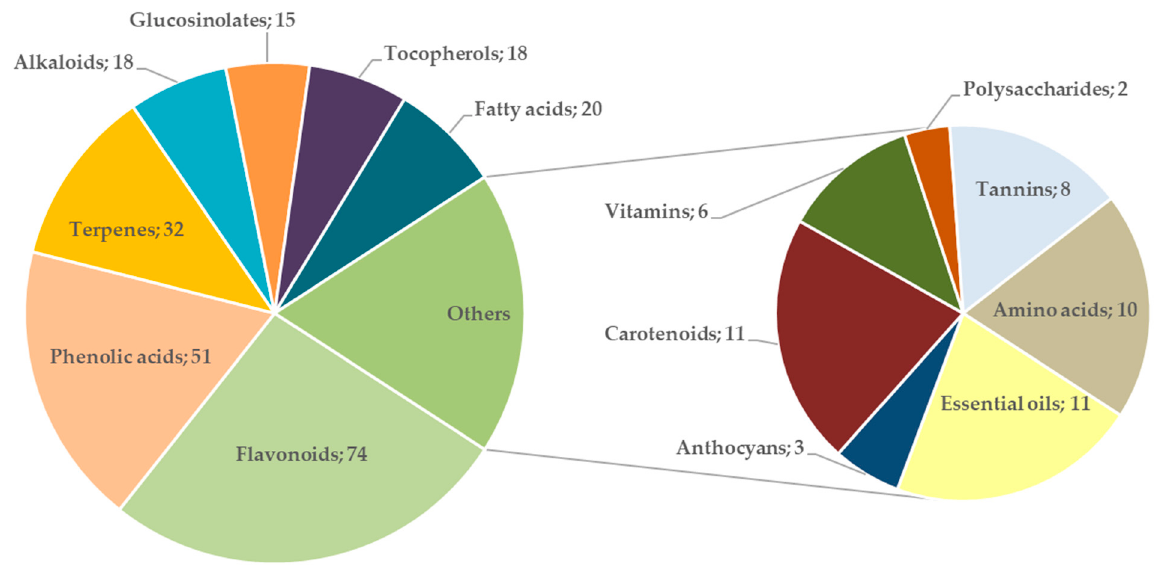
Figure 6. Major groups of compounds (calculated as percentage of the taxa) reported for the screened edible ruderals consumed in Bulgaria.